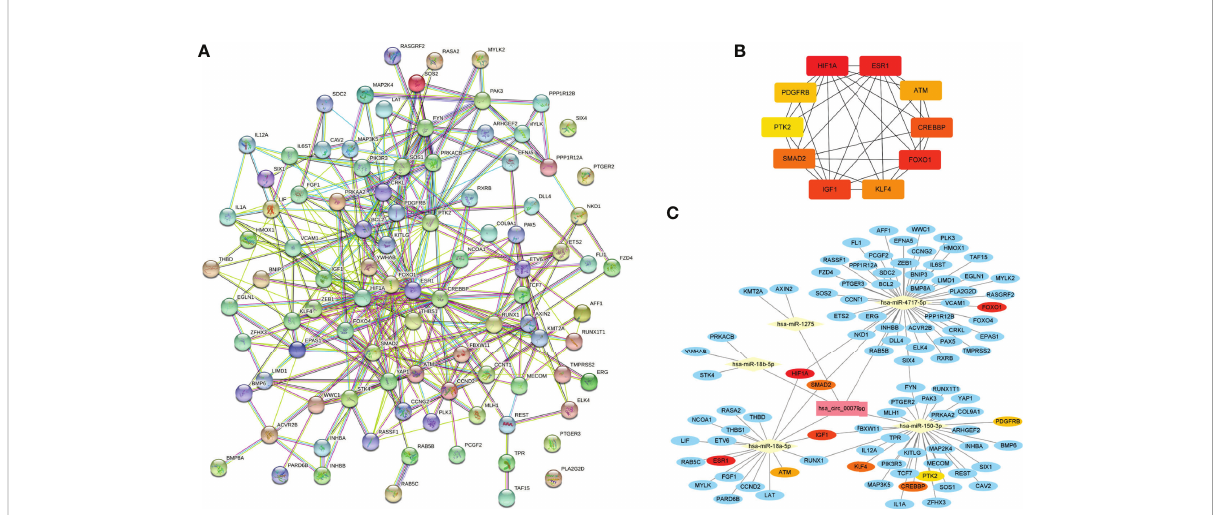
FIGURE 6 The circRNA-miRNA-mRNA regulatory network of hsa_circRNA_0007990. (A) Protein-protein interaction network obtained on STRING website. (B) Relationship network diagram of hub genes from protein-protein interaction network. (C) The reconstructed circRNA-microRNA-hub genes